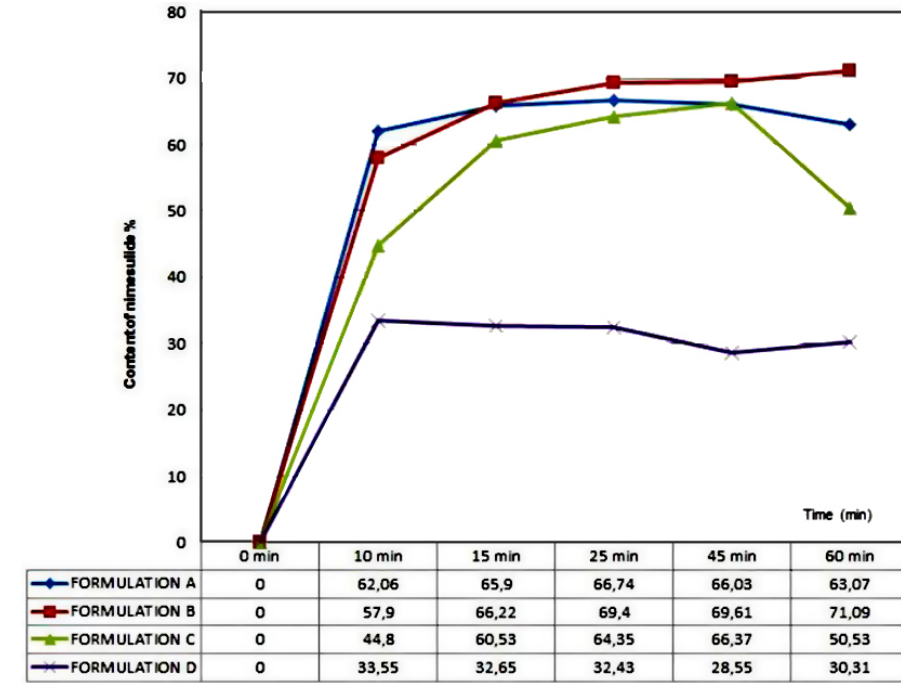
Figure 5. Nimesulide dissolution profiles from the examined formulations at pH